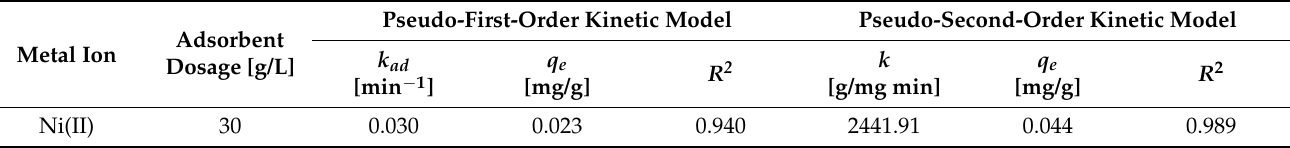
Table 4. Isotherm model parameters for adsorption of Ni(II) using SS-FA. Metal Ion